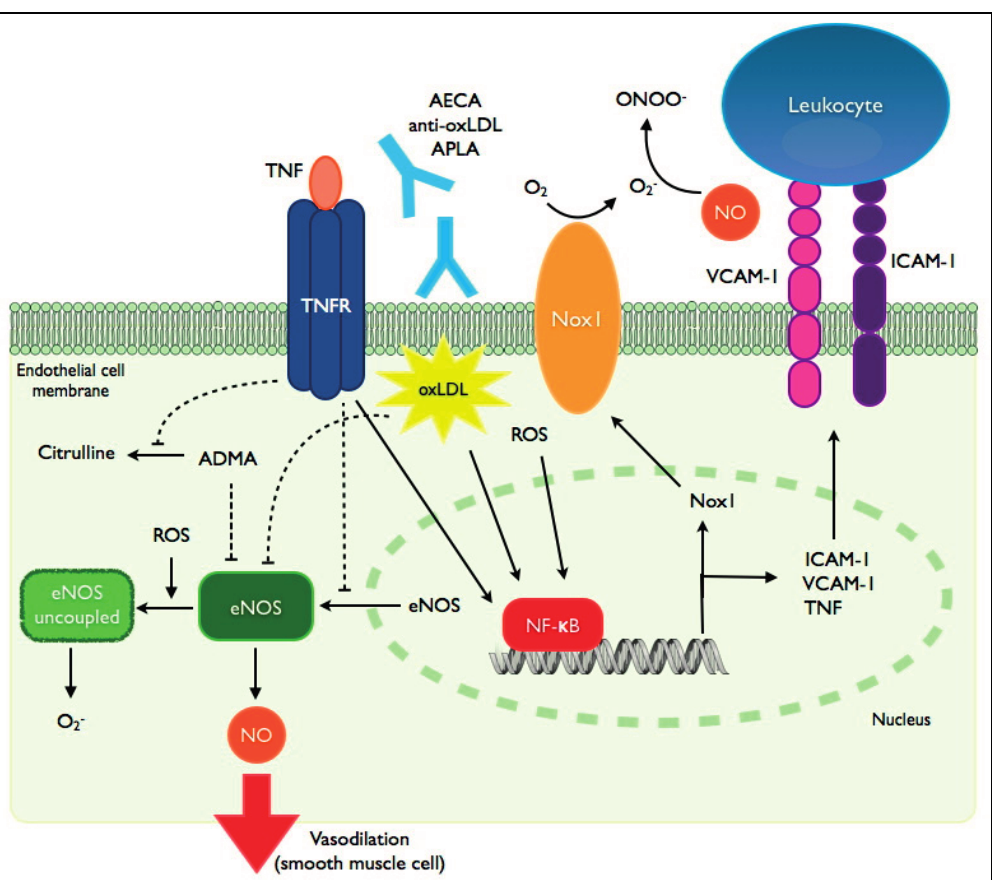
Figure 1. Mediators of endothelial dysfunction in inflammatory diseases. TNF- α (tumor necrosis factor- α ) exerts its effects on the endothelium through its receptor, TNFR. Binding of TNFR by TNF- α leads to diminished eNOS (endothelial nitric oxide synthase) protein expression via suppression of promoter activity and destabilization of its mRNA. TNFR suppresses eNOS activity by preventing the degradation of its endogenous inhibitor, ADMA (asymmetric dimethylarginine). TNFR signaling also induces the transcription factor NF- κ B leading to enhanced expression of intercellular adhesion molecules (ICAM-1: intercellular adhesion molecule-1; VCAM-1: vascular cell adhesion molecule-1), TNF- α and Nox1 (NADPH-oxidase-1). NF- κ B induction is also mediated by oxidized low density lipoprotein (oxLDL), reactive oxygen species (ROS) and binding of various autoantibodies (AECA: anti-endothelial cell antibodies; APLA: antiphospholipid antibodies; anti-oxLDL: anti-oxidized LDL antibodies). eNOS uncoupling, mediated in part by ROS, is associated with reduced NO (nitric oxide) production and enhanced generation of ROS. eNOS activity is also suppressed by